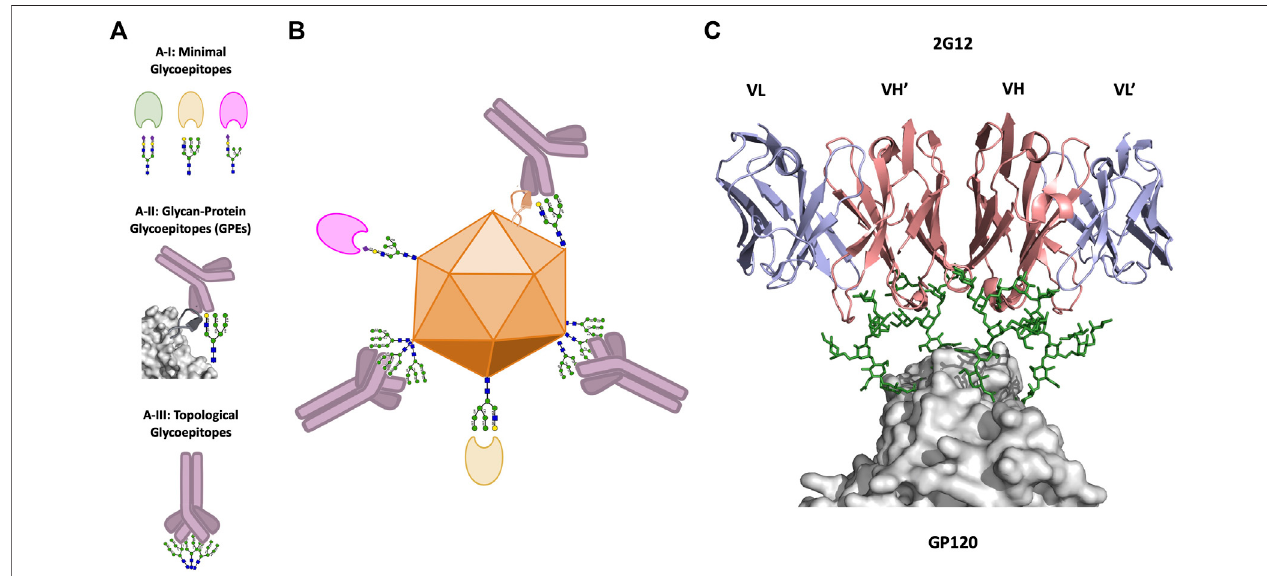
FIGURE 2 | Viral glycoepitopes. (A) , Viruses present three types of glycoepitopes for targeting by the host immune system. 2A – I: Minimal glycoepitopes consist of glycans which are effectively recognized speci fi cally by host lectins. 2A – II: Glycoprotein glycoepitopes (GPEs) include both glycan and peptide constituents, and are most effectively neutralized by Y-shaped mAbs. 2A – III: Topological glycoepitopes exist at clusters of high-mannose glycans, and are fl exibly recognized by X-shaped mAbs such as 2G12. (B) , illustration of the three types of glycoepitopes and their preferred mode of host-recognition. (C) , crystal structure of the interaction between the canonical topological glycoepitope on HIV and the X-shaped mAb 2G12 (PDB: 6OZC, Seabright et al., 2020). Heavy chains are shown in red, light chains are shown in blue, glycans are shown in green, and the virus protein surface is shown in gray (PyMol,